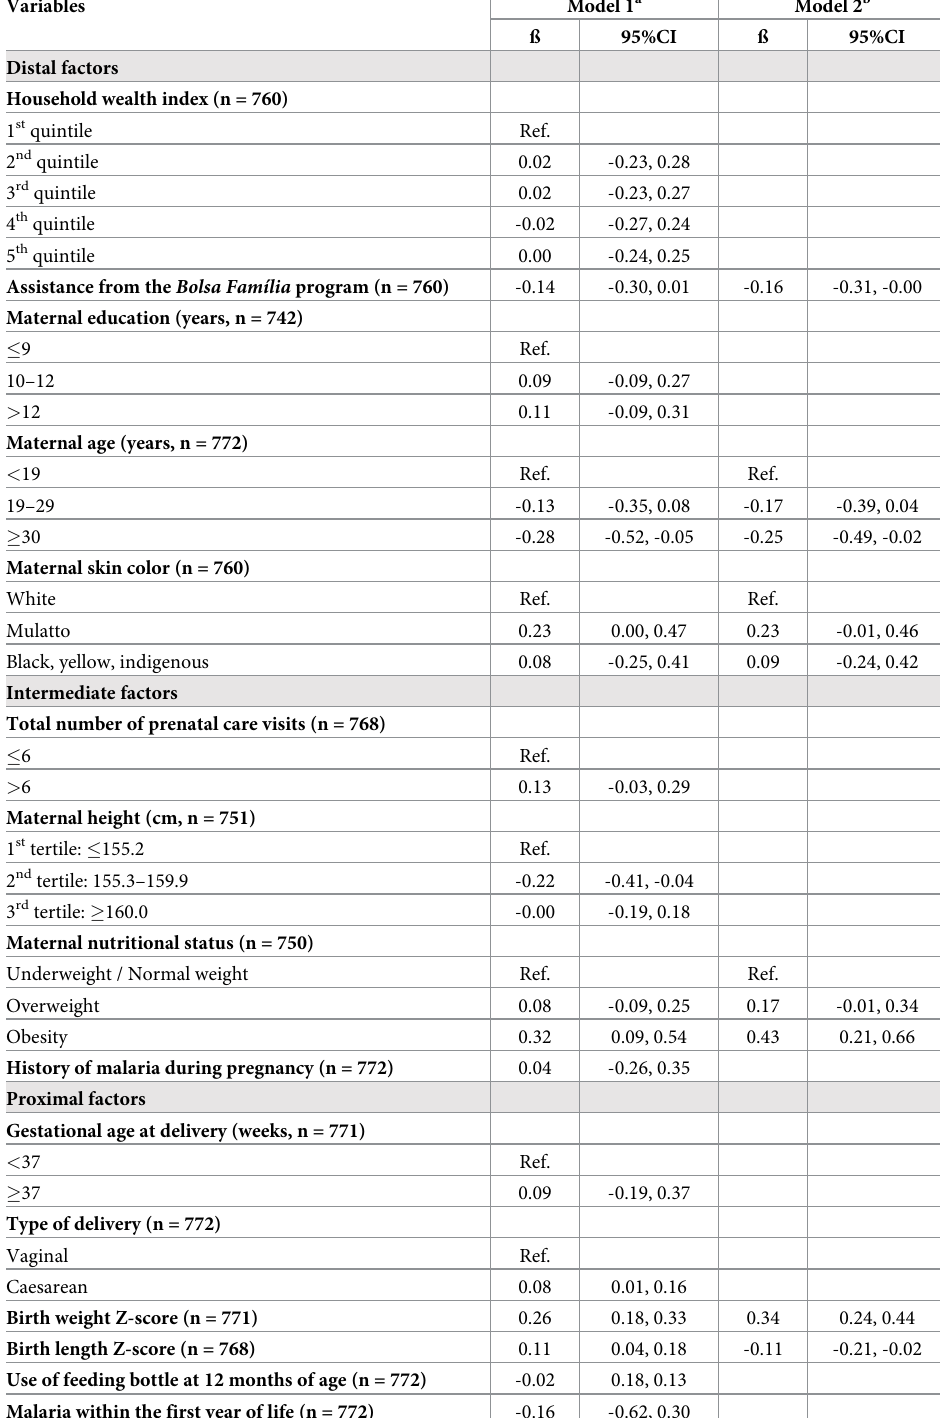
Table 3. Adjusted linear regression coefficients of factors associated with BMI-for-age Z score (BAZ) at 10–15 months of age, MINA-Brazil Study, Cruzeiro do Sul, Acre,